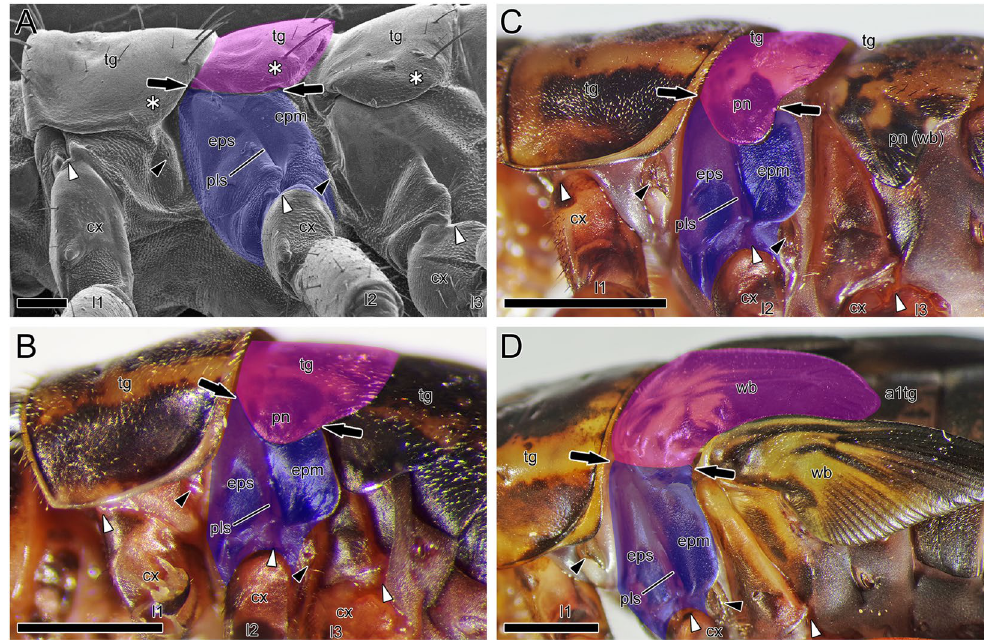
Figure 6. Gryllus bimaculatus nymphs, lateral views. ( A ) First instar nymph, SEM. ( B ) Fifth instar nymph. ( C ) Tenth instar nymph. ( D ) Eleventh instar nymph. See text. Abbreviations: a1tg, first abdominal tergum; cx, coxa; epm, epimeron; eps, episternum; l1-3, pro-, meso- and metalimbs; pls, pleural suture; pn, paranotum; tg, thoracic tergum; wb, wing bud. Color highlights: blue, pleural territory; magenta, tergal territory. Arrows, black and white arrowheads, and asterisks show the BTA, spiracles, pleuro-coxal joints, and regions corresponding to the paratergal bulge, respectively. Bars: 100 µ m ( A ) ; 1 mm ( B ) ; 2 mm ( C , D